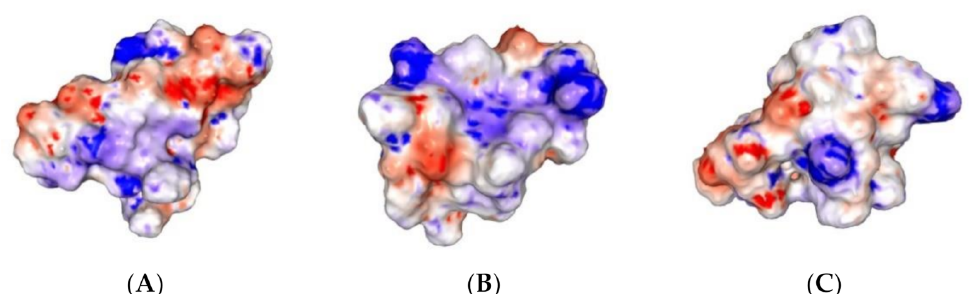
Figure 7. 3D electrostatic potential map on SASA visualized by PBEQ Solver. ( A ) A β peptide; ( B ) A β peptide and CU; ( C ) A β peptide and FA. Areas with negative potential ( − 2 kcal/(mol.e)) are given in red, areas with positive potential (+2 kcal/(mol.e))–in blue, areas with neutral potential–in